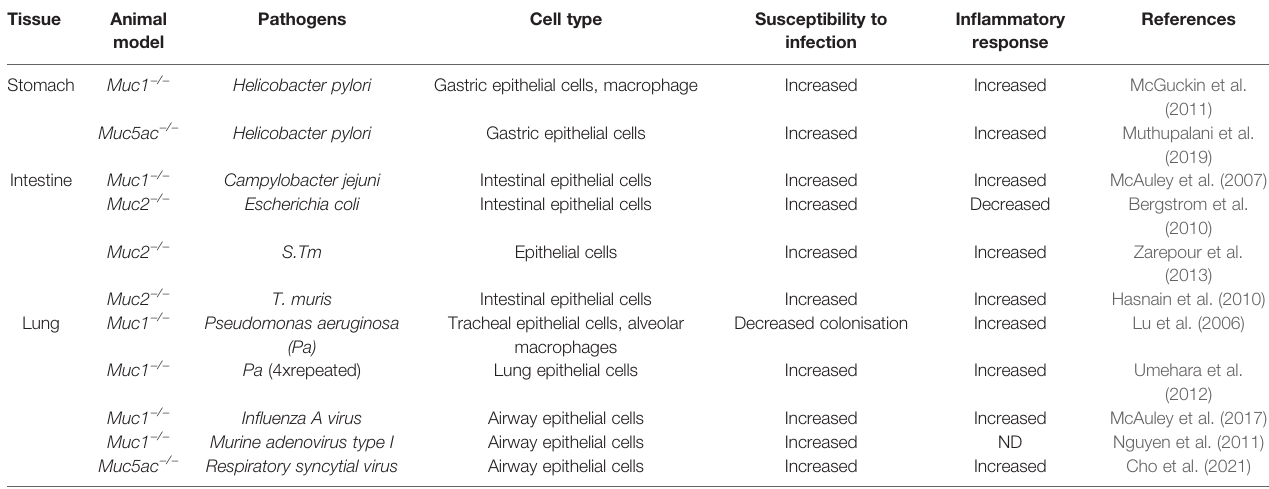
TABLE 2 | Mucin mouse models for study